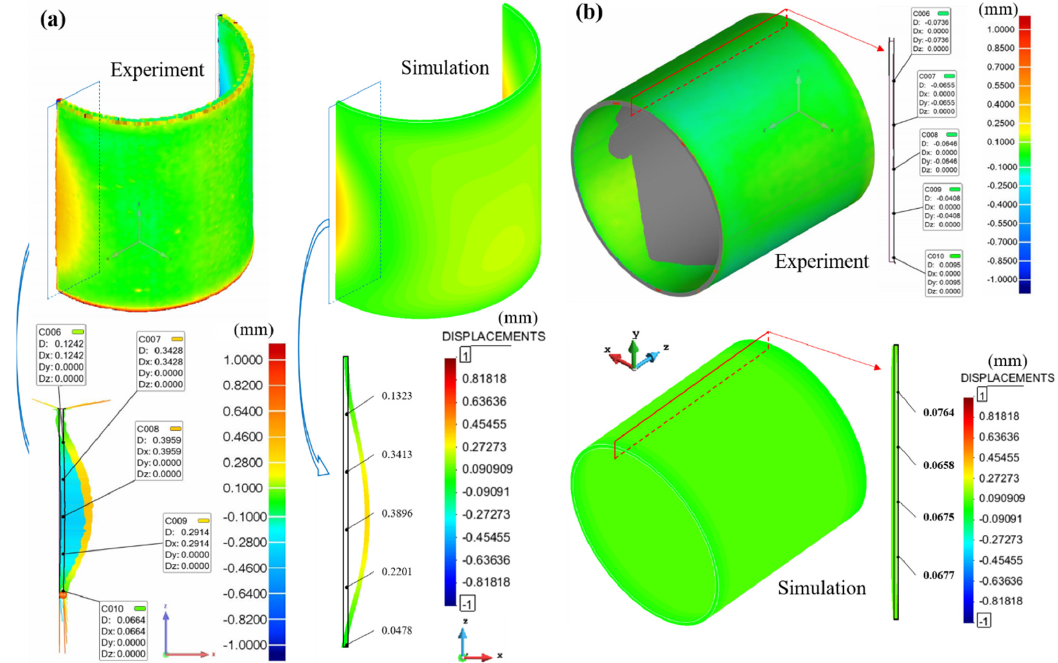
Figure 10. Comparison of the out-of-plane displacement fields obtained through 3D scanning and numerical simulation: ( a ) semi-cylinder; ( b ) cylinder.